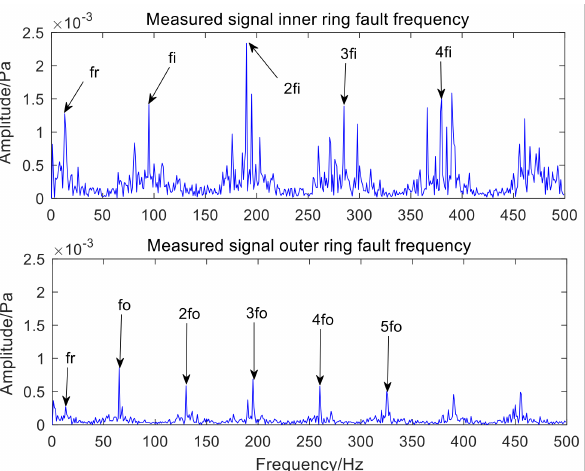
Figure 17. The envelope spectrum of an acoustic signal using the AVMD-IMVO-MCKD.